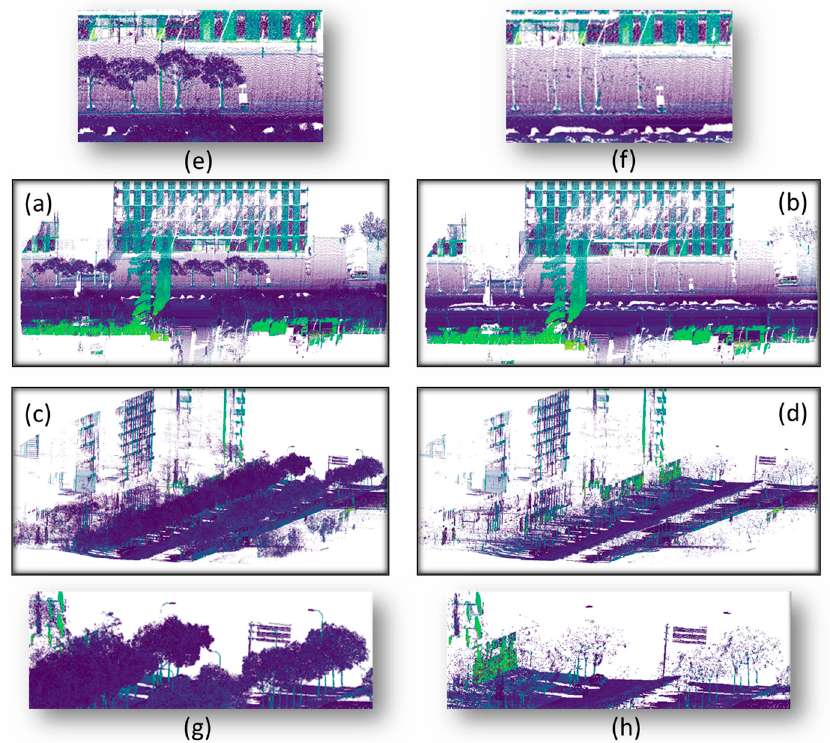
Figure 13. The visual results of multiscale dimensionality criterion classification: ( a ) Front-view images before classification; ( b ) Front-view images after classification; ( c ) Oblique view images before classification; ( d ) Oblique view images after classification; ( e ) Enlarged display of the classification results in ( a ); ( f ) Enlarged display of the classification results in ( b ); ( g ) Enlarged display of the classification results in ( c ); ( h ) Enlarged display of the classification results in ( d );